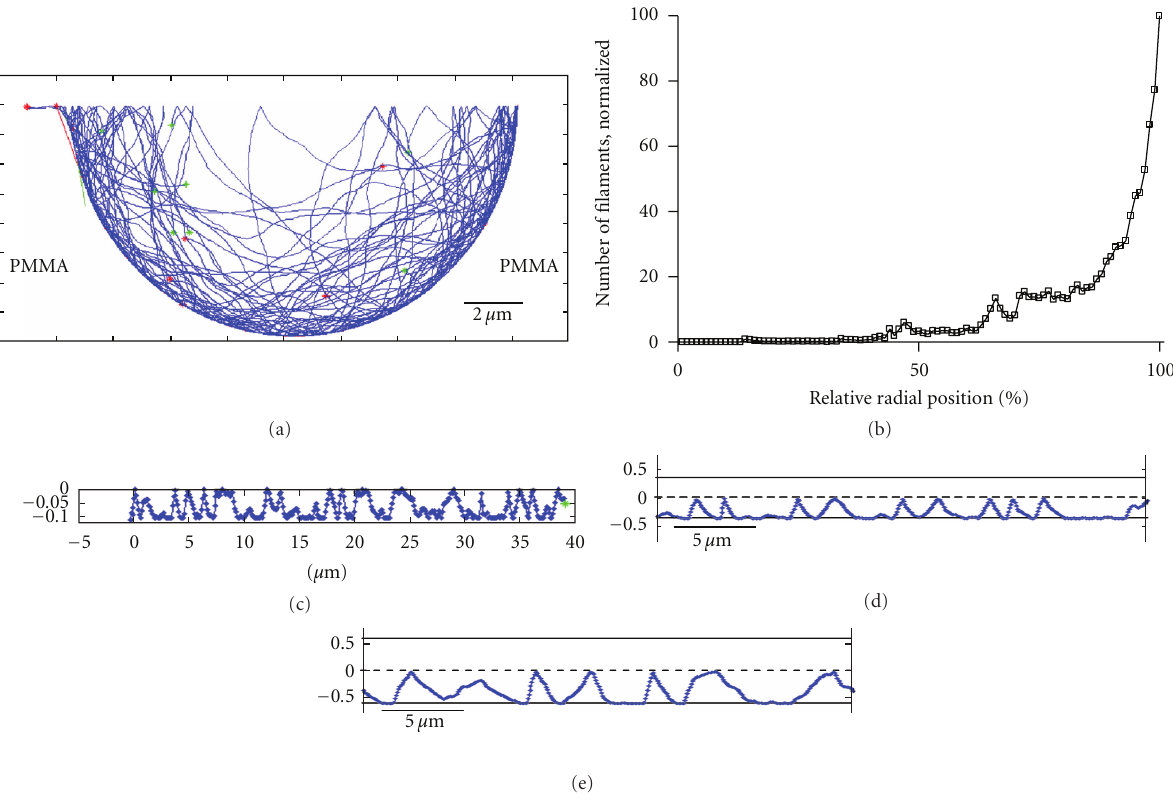
Figure 5: Monte-Carlo simulations of actin filament paths for the experimental situation in Figures 4(b) and 4(c) with 8 motile filaments (10 filaments in the simulations for practical reasons), a velocity of 3 μ m/s, and a total integration time of 60 s. (a) Simulated filament paths (blue) with starting points (green) and end-points (red). The motility supporting area is indicated by weak red (circular part) and green (to the far left; polynomial part) lines. For symmetry reasons, the simulations were limited to a half-circular shape which simplified the algorithm. Thus, filament paths are reflected in the top border of the simulated area, corresponding to their motility with unchanged sliding direction past this border. (b) The radial distribution of filament positions accumulated during the entire simulation period. Here, 0 corresponds to the centre of the circular motility supporting zone, and 100% corresponds to the border with the LOR/PMMA-area. (c) Simulation of sliding along 200 nm wide track similar to that in Figure 1. Simulation limited to lower half of the track with reflection of filament paths in track midline (top of diagram). Thus, simulated filament paths at bottom of figure correspond either to motility at the lower or top edge of the track. (d) Simulation of sliding along 700nm wide track (delimited by upper and lower full lines) as in Figure 4(d). Simulation only for lower half of track with reflection in midline (dashed line) as in Figure 5(c). (e) Simulation as in Figure 5(d) but track width increased to 1.2 μ